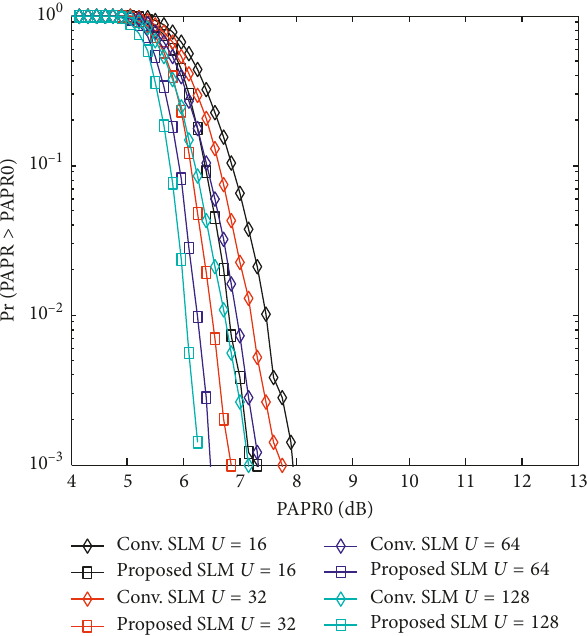
Figure 15: Comparison of SLM given in [5] with the proposed SLM for U � 16, 32, 64, and 128, N � 128, and 8-PSK.